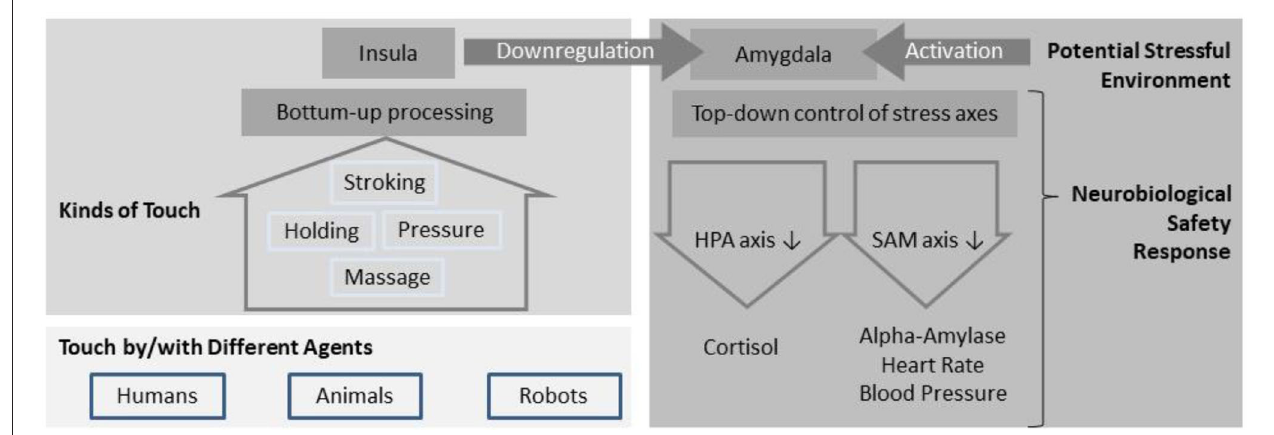
FIGURE 1 | Mechanisms of touch potentially acting as safety signal: In a dangerous environment, the amygdala is activated in order to allow for rapid reactions via the stress axes (e.g., fight or flight response). Tactile perception from different social and non-social contexts is processed in the insular cortex, which has a regulating influence on the amygdala and can therefore dampen the stress response. A calming or relaxing effect of touch might therefore be based on signaling safety (absence of danger) on a neurobiological